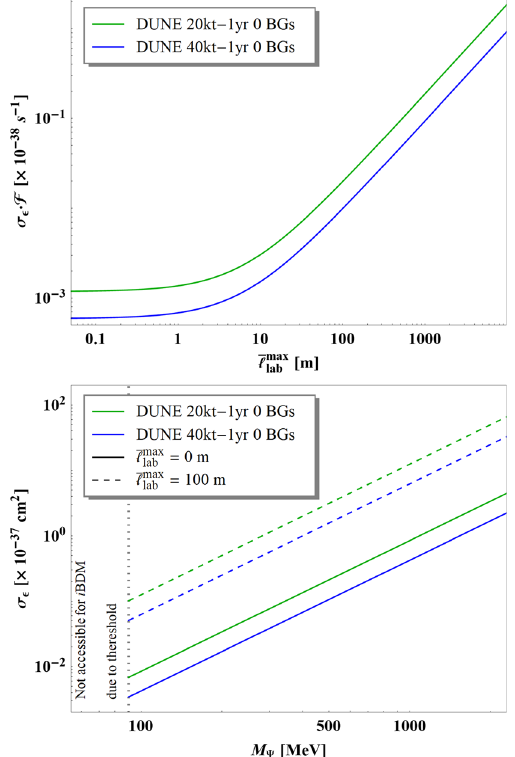
Fig. 22 Top: model-independent experimental sensitivities of i BDM − σ (cid:12) · F plane. The reference experiments are DUNE search in ¯ (cid:20) max lab 20kt(green),andDUNE40kt(blue)withzero-backgroundassumption for 1-year time exposure. Bottom: Experimental sensitivities of i BDM = 0 and 100 m are search in M Ψ − σ (cid:12) plane. The sensitivities for ¯ (cid:20) max lab shown as solid and dashed lines for each reference experiment in the top panel